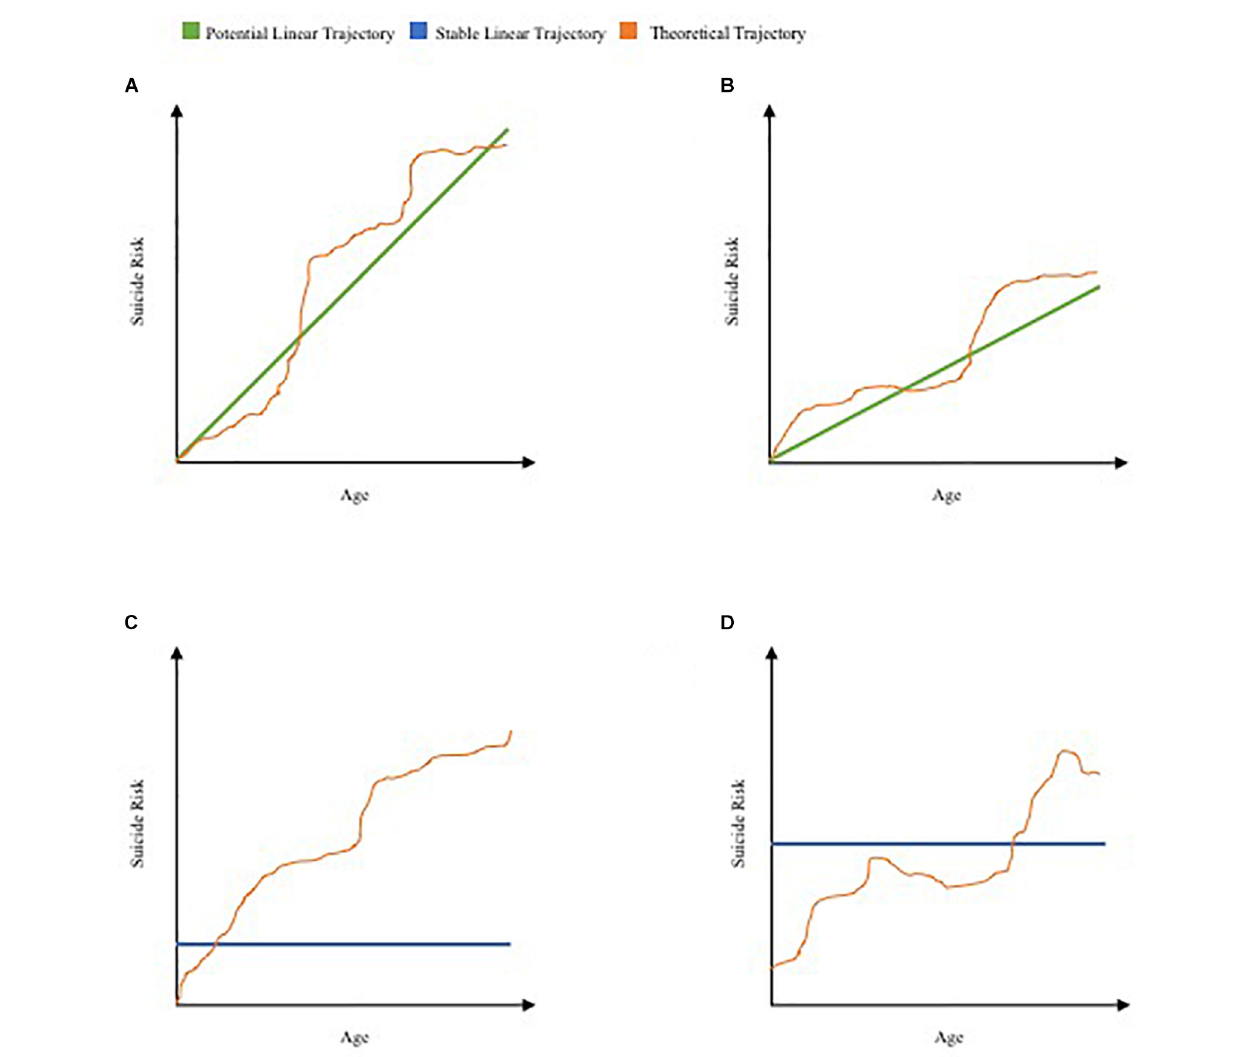
FIGURE 2 | Proposed schematic of theoretical life trajectories of suicide risk. Theoretical trajectories suggested as deviations from four of infinite potential linear systems over time, analogous to graphical illustration of CDC data. (A) Theoretical trajectory of early suicide risk superimposed on positively correlated linear trajectory of suicide risk and age. (B) Theoretical trajectory of late-life increase in suicide risk superimposed on positively correlated trajectory of suicide risk and age. (C) Theoretical trajectory of ongoing increase in suicide risk superimposed on an ideally stable linear trajectory. (D) Theoretical trajectory of variable deviations in suicide risk superimposed on a second (potential) ideally stable linear